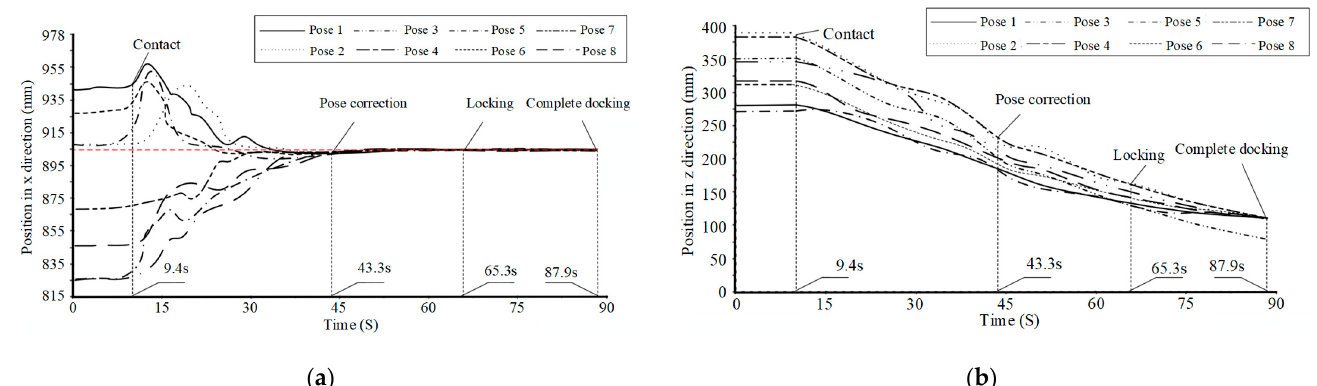
Table 3. The initial docking conditions of the simulation analysis for eight initial pose conditions